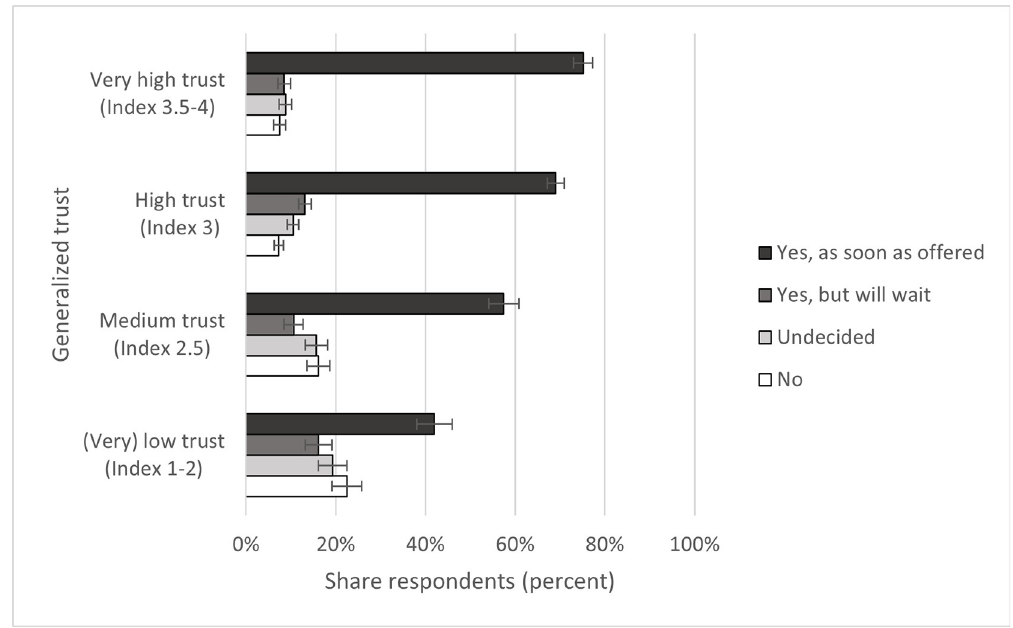
Fig 1. Generalized trust and vaccine acceptance. Data: SOEP-CoV survey. Own calculations, weighted. 95% confidence intervals.